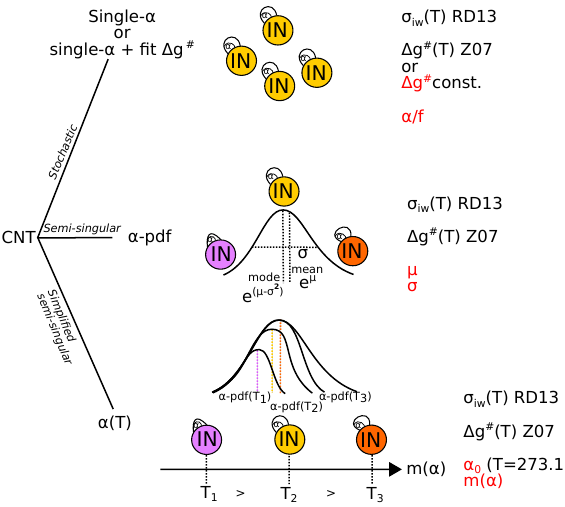
Figure 1. Schematic sketch of different contact angle schemes in which the fit parameters for each contact angle scheme are marked in red. Stochastic: all IN have the same contact angle α (single- α ). The ice germ with the contact angle α is shown in the sketch. Semi-singular: different IN have different contact angles. The con- tact angles are distributed with an α -pdf over the IN population. The sketch shows three contact angles α 1 (purple), α 2 (yellow), and α 3 (orange) of the contact angle distribution. The most efficient con- tact angle α 1 is the smallest ( < α 2 < α 3 ). Simplified semi-singular: all IN have the same contact angle. The contact angle changes with T ( α 1 < α 2 < α 3 in the example). α is equivalent to the mean con- tact angle of the α -pdf scheme (e µ ) or mean activity of the α -pdf distribution, which changes with temperature. Figure adapted from F.